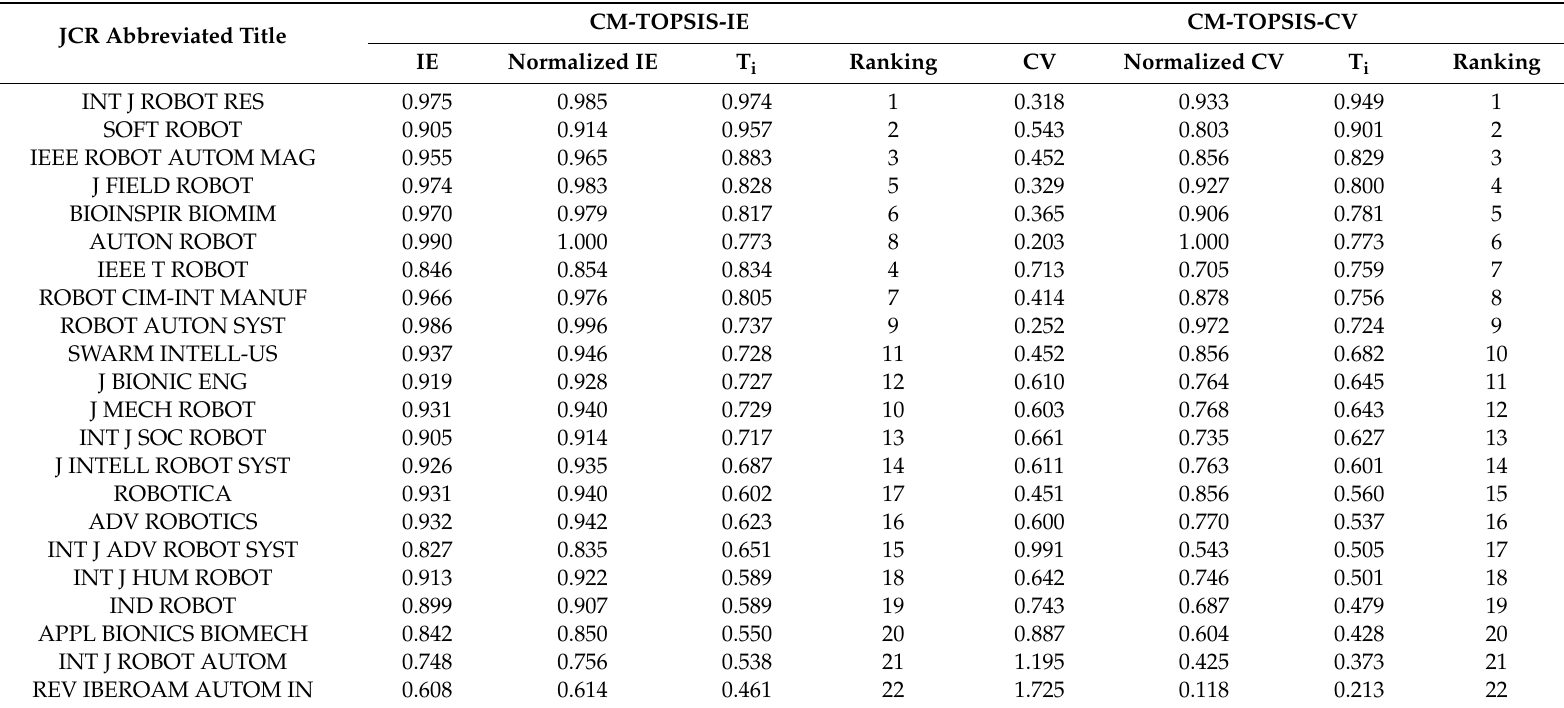
Table 3. Evaluation results of CM-TOPSIS-IE and